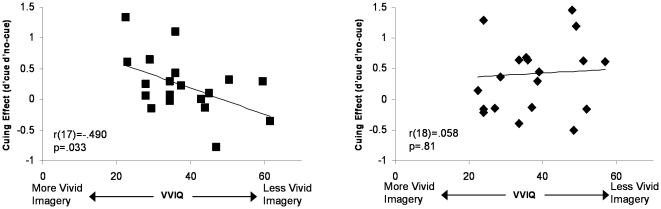
Results from Experiments 3 and 4.Left: Effects of auditory cues on the detection of cued visual objects versus objects cued with the uninformative word “ready” (Experiment 3). Right: Results from Experiment 4 in which the position of the to-be-detected stimuli was made unpredictable through random jitter. Bars indicate ±1 SE of the difference between the means.